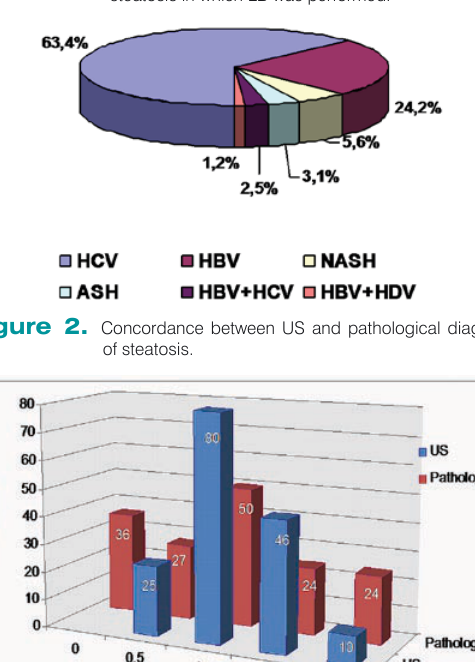
Table 1. The prognostic value of US examination for the assessment of liver steatosis.